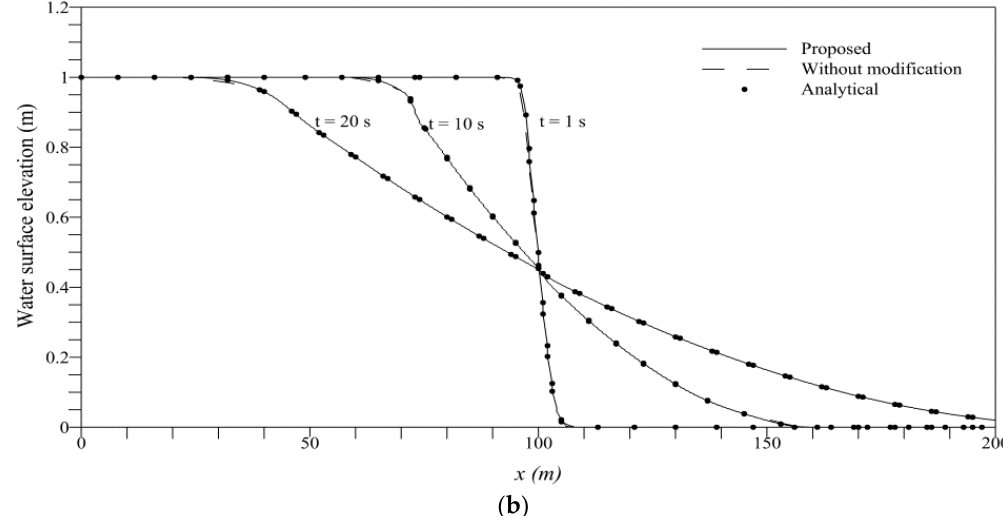
Figure 1. Comparison of water levels for dam-break over rigid bed for: ( a ) wet bed; and ( b ) dry bed.